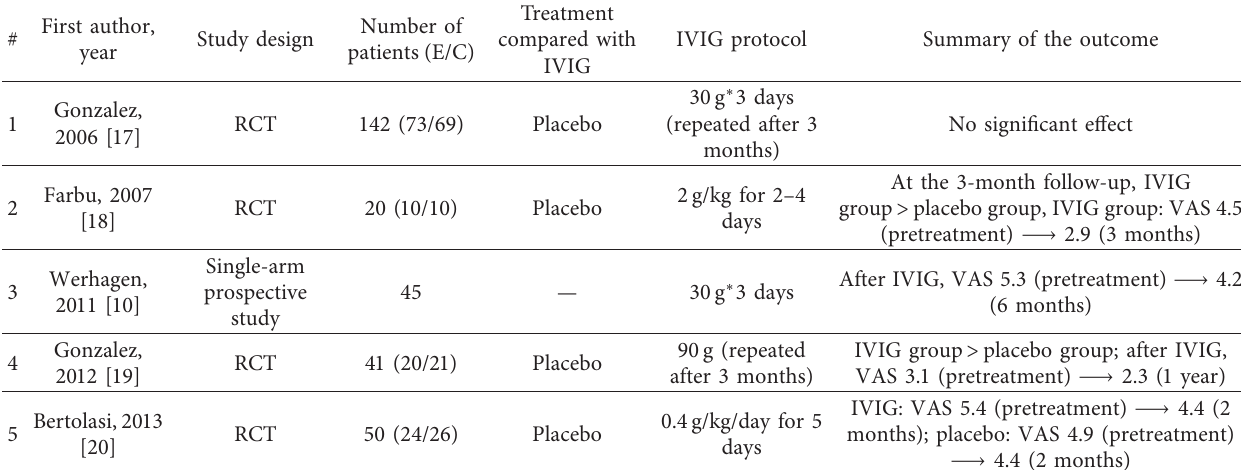
Table 1: Summary of the included